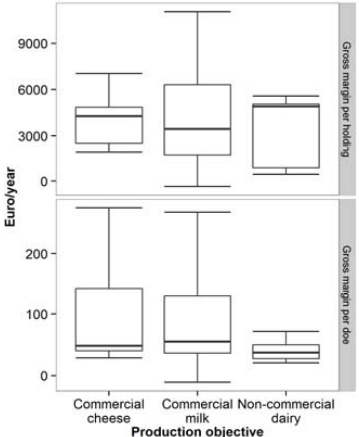
Figure 6. The annual gross margin per holding and annual gross margin per doe on goat holdings in northern Morocco based on monthly data collections between September 2009 and August 2012. Holdings were classified by dairy production status: commercial milk, commercial cheese and non ‐ commercial dairy.